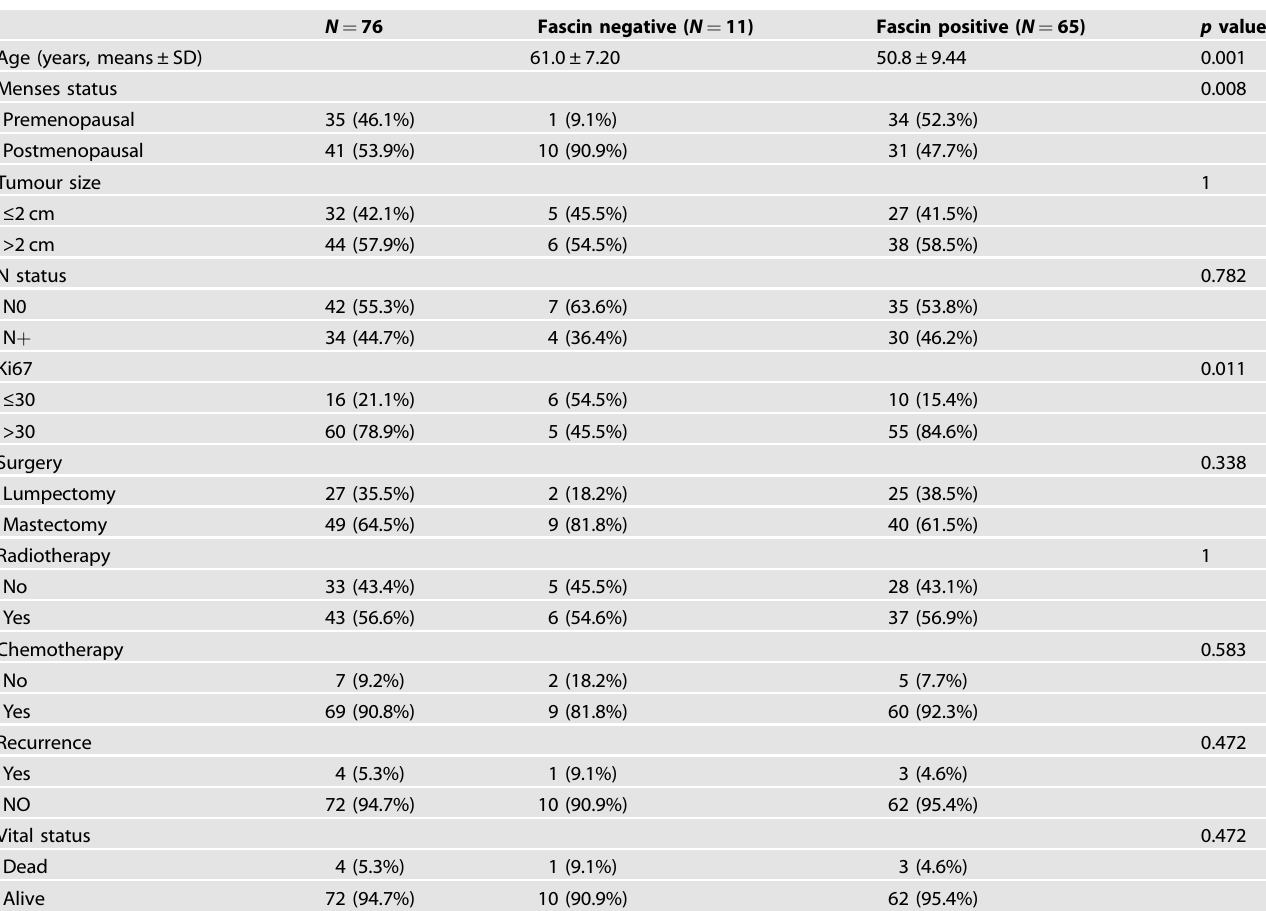
Table 1. Correlation of Fascin expression and clinicopathological features in